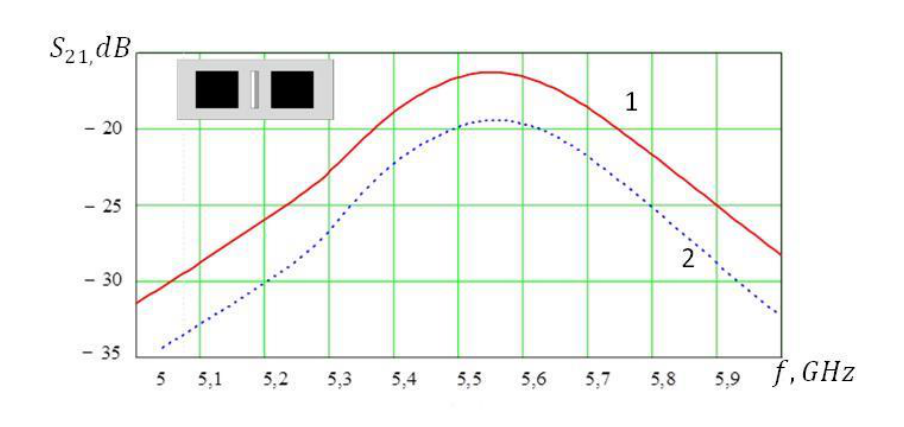
Fig. 2. Frequency dependence mutual coupling coefficient: 1 – reference antenna; 2 – antenna under test